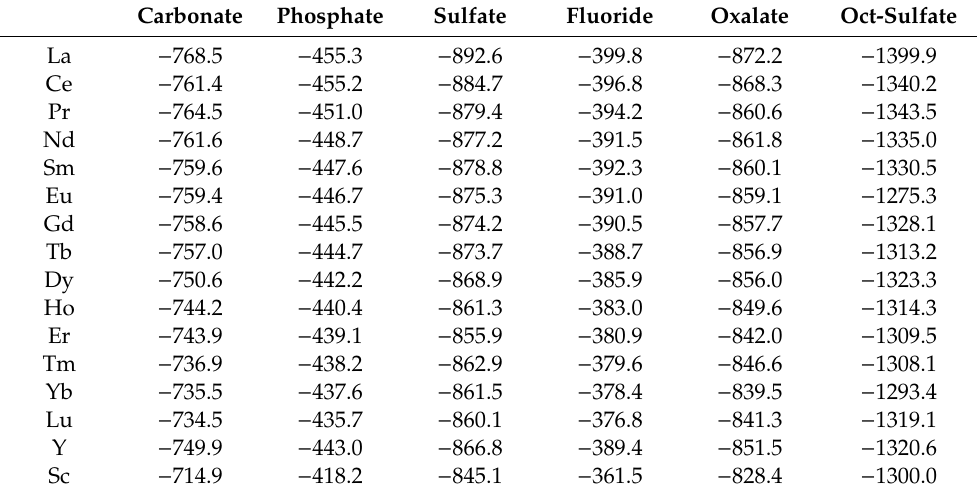
Table 2. The Gibbs standard free energy formation of various compounds in kCal / mol. Information taken from [14,15] with some